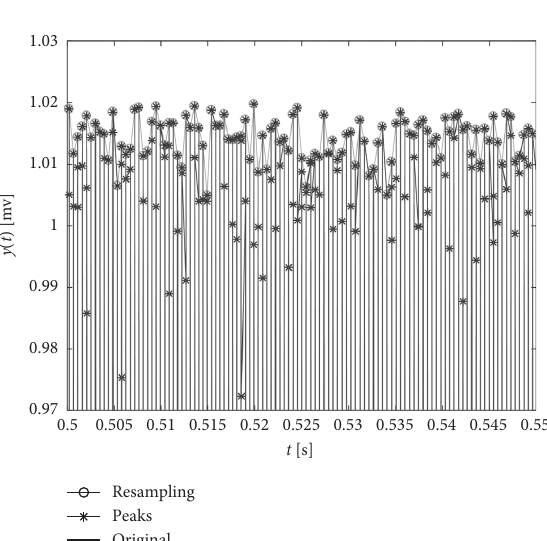
Figure 11: Reference phase t